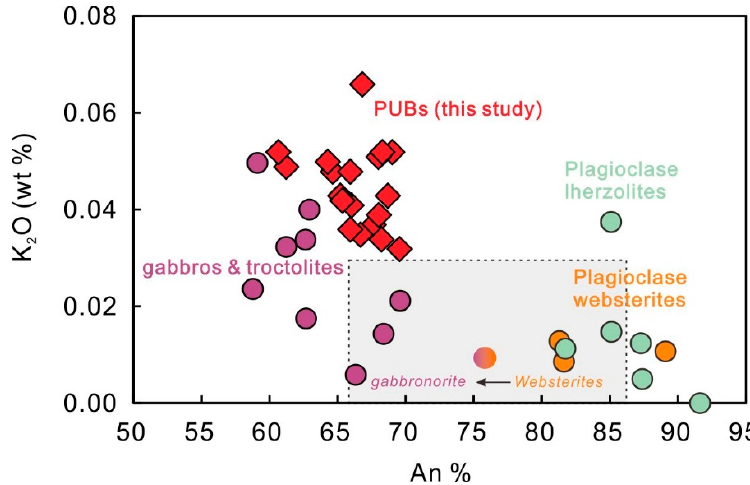
Figure 10. Plots of K 2 O content as a function of anorthite content (An) for plagioclase in Mount Jourdanne PUBs. The plagioclase in the plagioclase-bearing ultramafic to gabbroic suites (data from Paquet et al. [30]) are also plotted for comparison. The grey field corresponds to the compositional range of plagioclase in sample SMS6-5-7 (see Paquet et al. [30] for details). In this sample, the plagioclase abundances vary significantly over scales of a few centimeters, with modal mineralogy varying from websterite to gabbronorite.